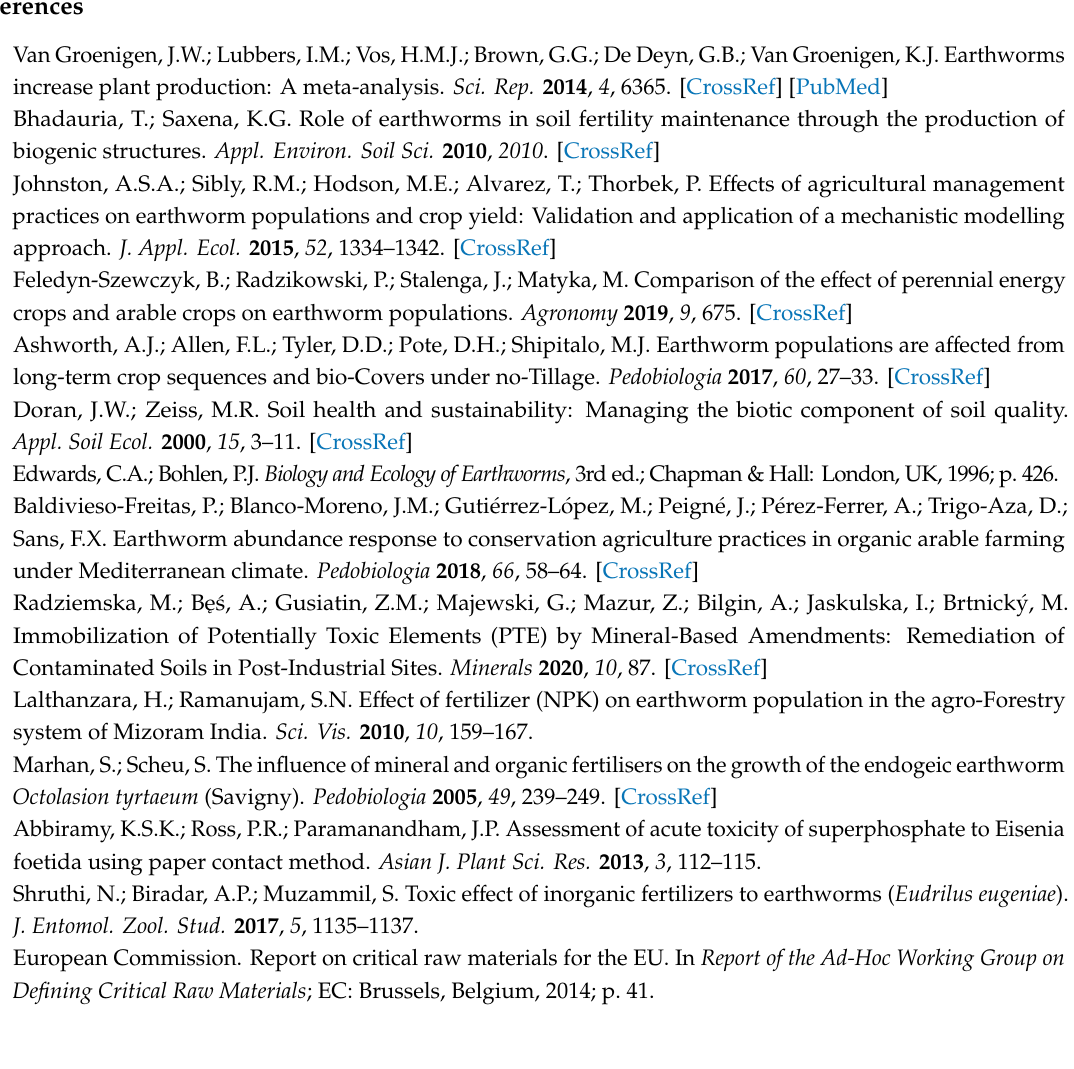
Figure S1: Scheme of experimental